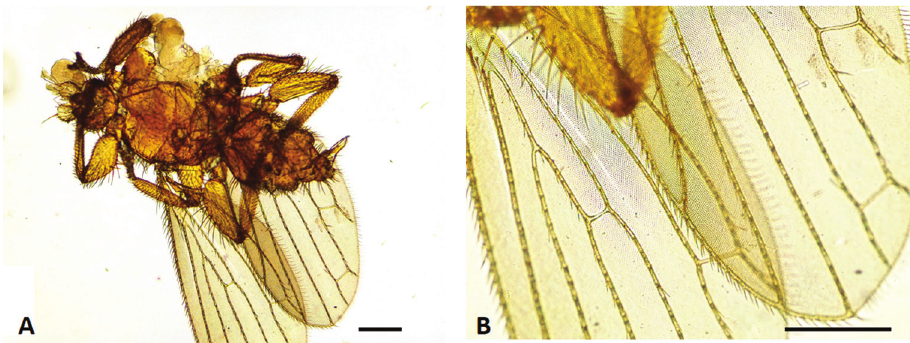
Figure 3. A dorsal view of Trichobius sp., 40× magnification B detail of wing, 100×. Leica DM500 opti- cal microscope. Scale bars: 0.5 mm ( A, B